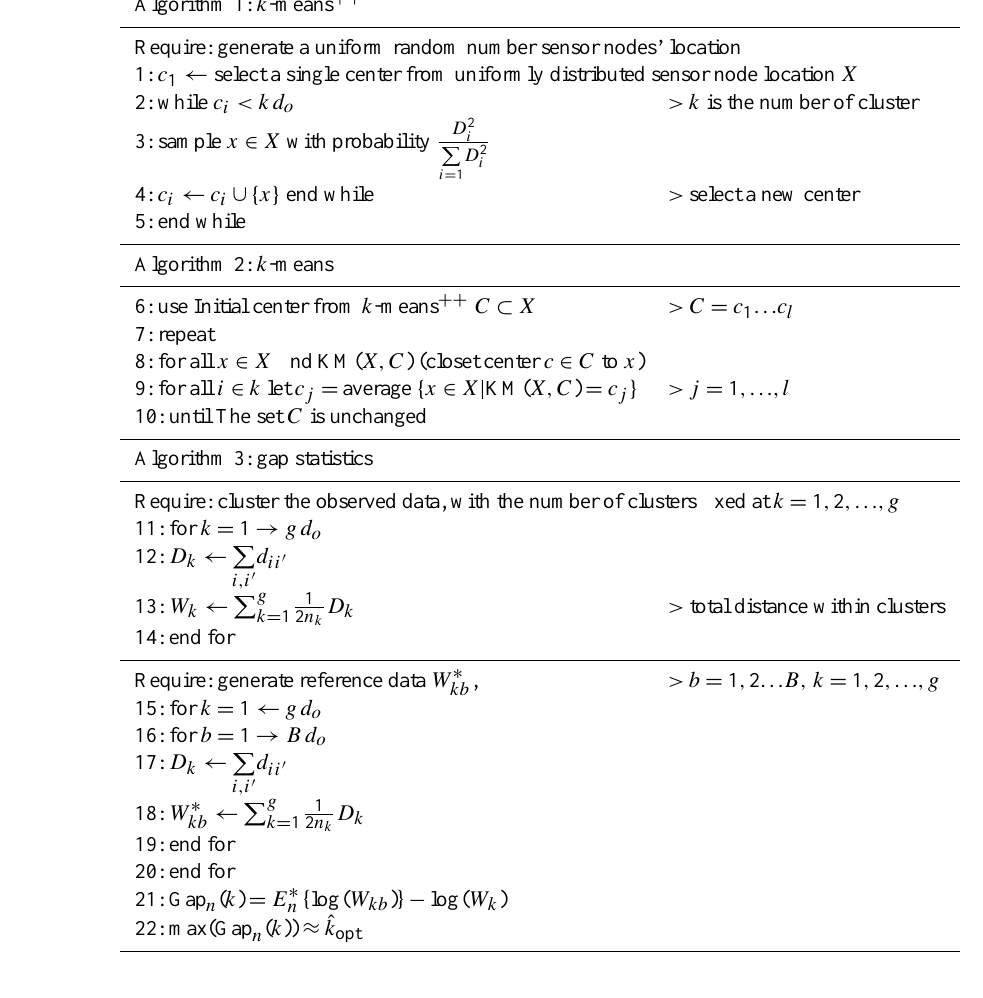
Table 2. Combination of clustering algorithms. Algorithm 1: k -means ++